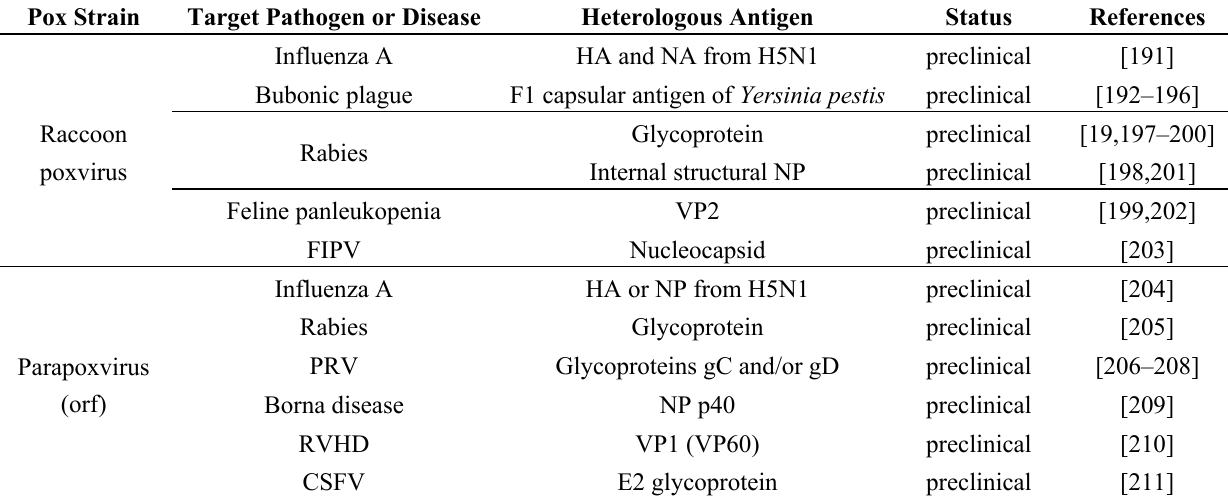
Table 5. Preclinical studies using other pox vectors as vaccine candidates against different viral, bacterial and parasitic infectious